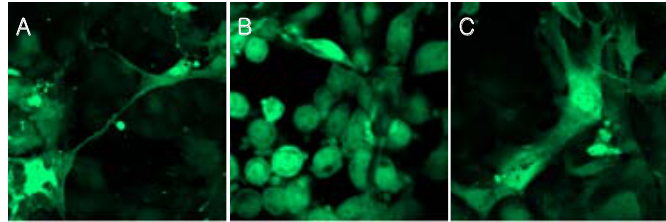
FIGURE 1 - Differentiation of EK1 cells with EGFP fluorescence expression. All the cells with bright EGFP showed their specific morphology of the differentiated cells at 40 th passage. A , cells with projections; B , cells with round form; C , polygonal cells (200x).